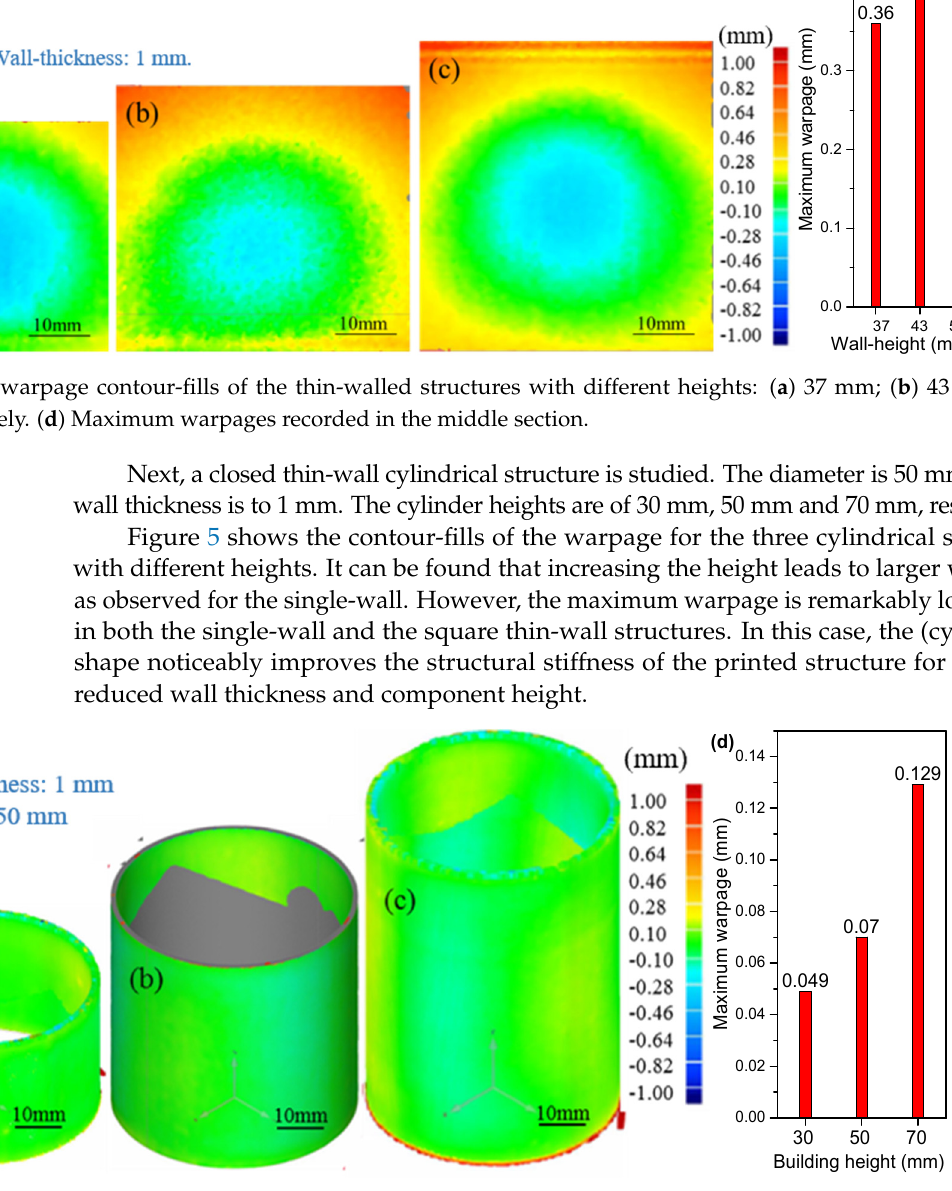
Figure 5. Contour-fills of the final warpage of the cylindrical thin-wall structures with different building heights: ( a ) 30 mm; ( b ) 50 mm; ( c ) 70mm, respectively. ( d ) Maximum warpages recorded in the middle section.